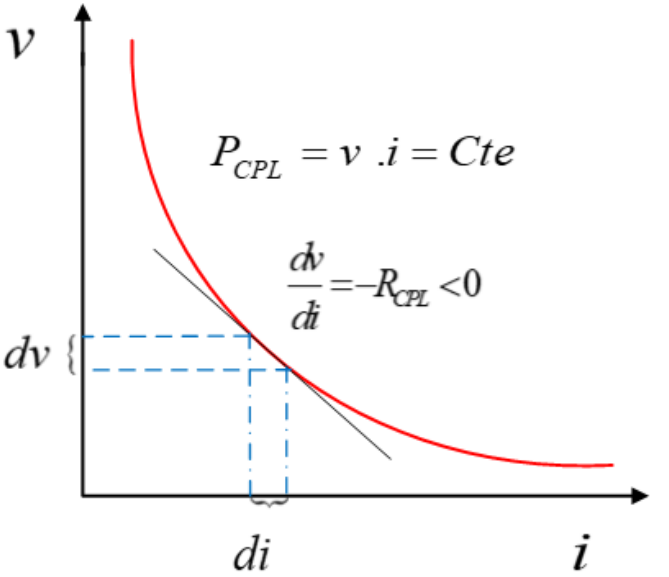
Figure 4. Incremental negative impedance behavior of a CPL.